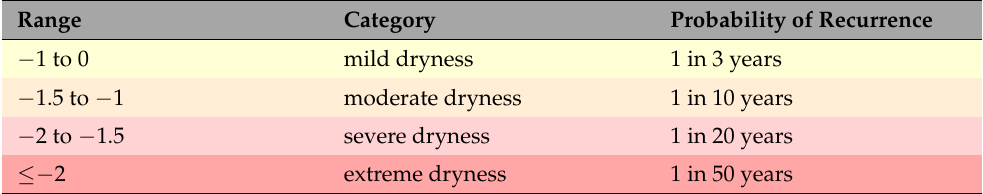
Table 2. Standardized Precipitation Index (SPI) and Standardized Precipitation-Evapotranspiration Index (SPEI) categories and their probability of